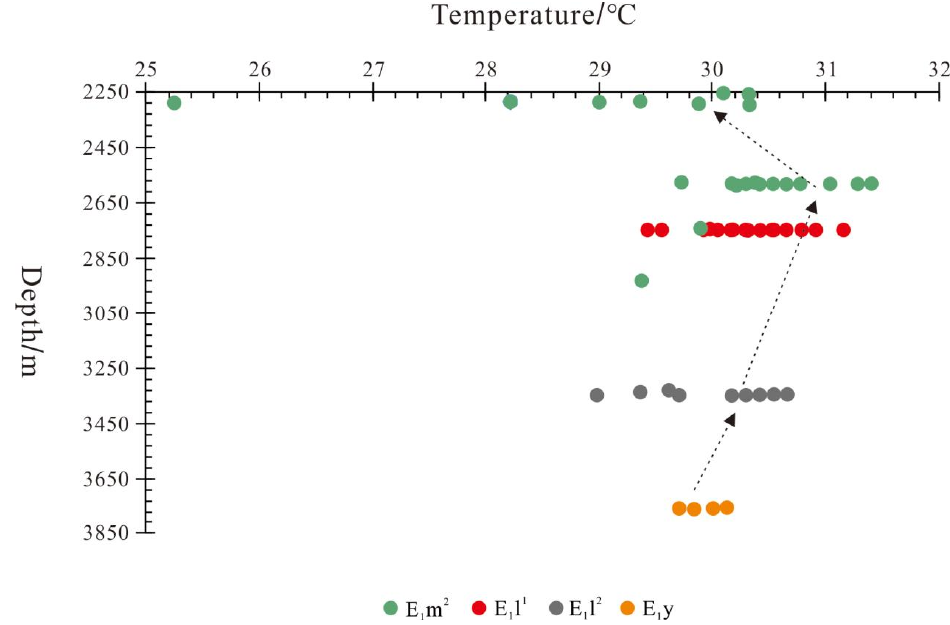
Figure 10. The relationships between the paleotemperature and depth in the West Lishui Sag.